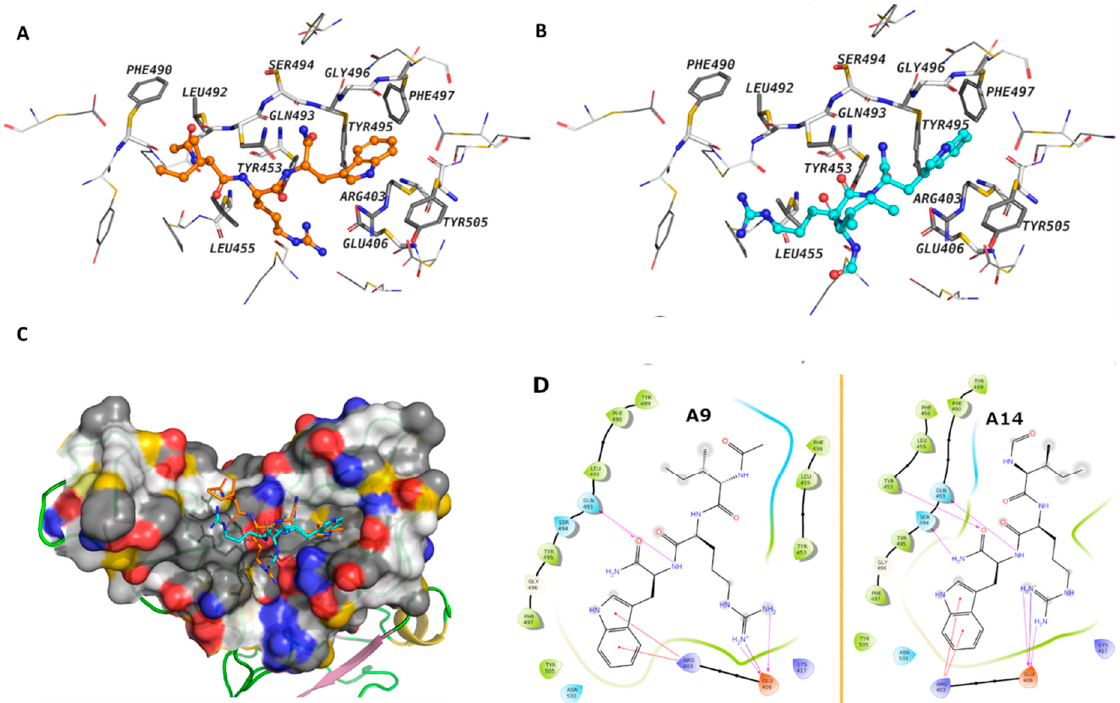
Figure 3. The binding modes of peptides A9 and A14. ( A , B ) A9 and A14 are shown as balls and sticks, the amino acids that are within 4Å of the peptides are labeled and shown as sticks ( C ) the surface cavity of the RBD is shown as molecular surface and ( D ) The 2D interaction diagram of A9 and A14. The surface is colored with the YRB scheme, yellow for the carbon atoms with high potential to form hydrophobic interactions, blue for the sidechain nitrogen atoms of arginine and lysine, and red for the sidechain oxygen atoms of glutamate and aspartate.